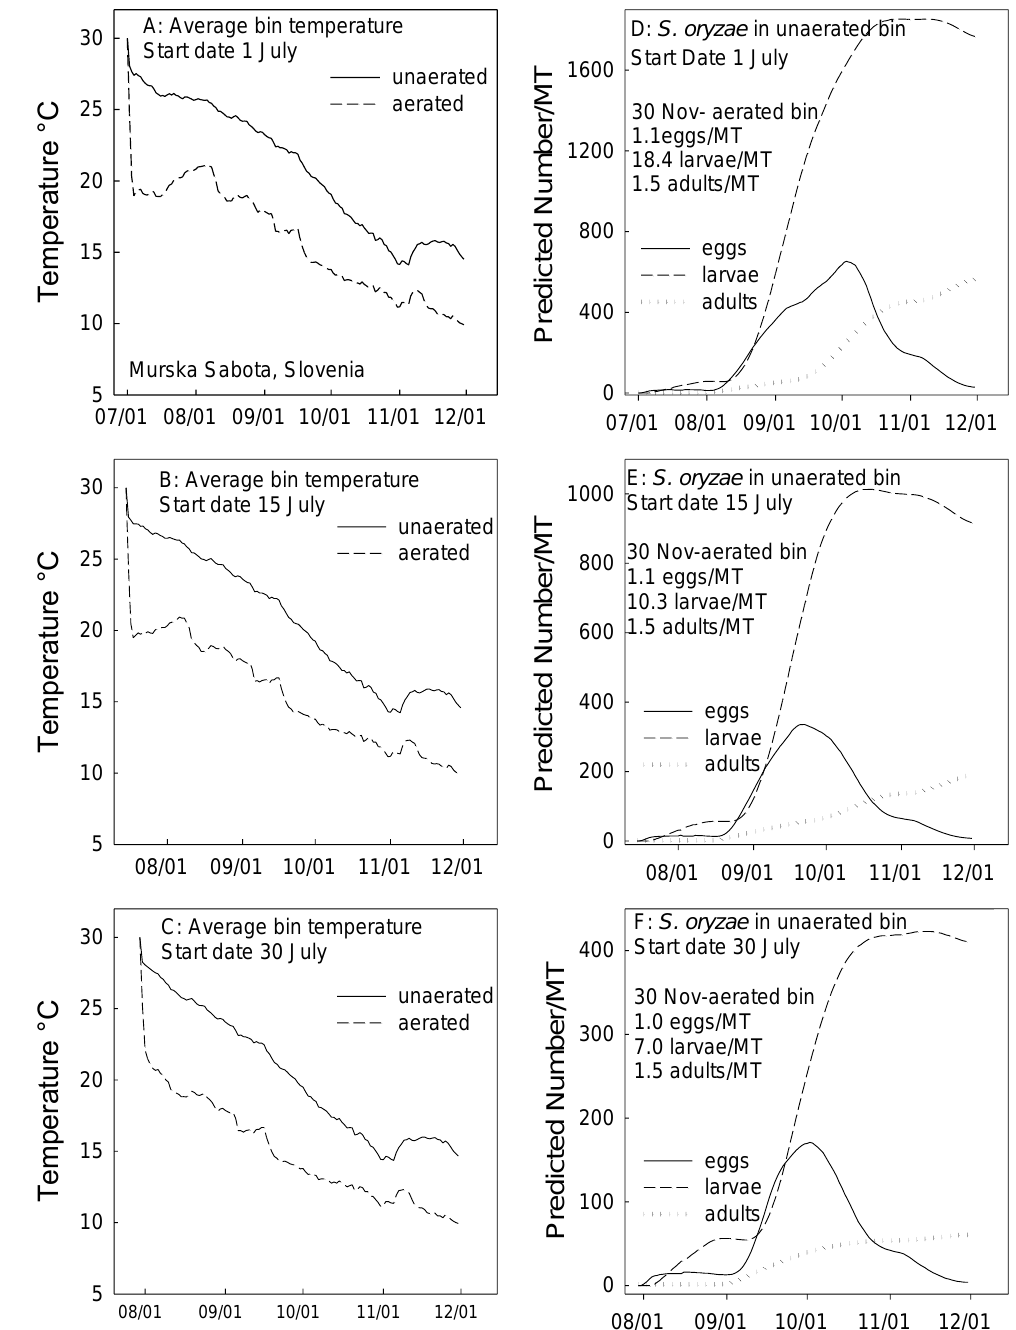
Figure 5. Predicted average bin temperatures in unaerated (solid line) and aerated wheat (dashed line) for wheat stored in Murska Sabota, Slovenia, with start dates of 1, 15, and 30 July ( A – C ). Predicted populations of eggs, larvae, and adult S. oryzae (solid line, dashed line, dotted line, respectively) in unaerated wheat with those start dates are plotted in ( D – F ). Data for predicted populations of eggs, larvae, and adults in aerated wheat are given as text inside ( D – F ).